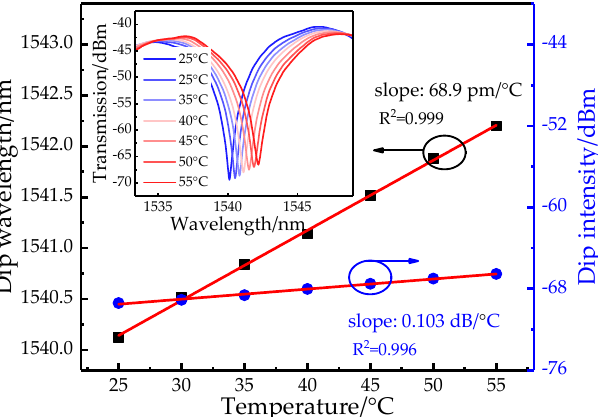
Figure 7. The wavelength and intensity responses with varied temperature. Inset: transmission spectra of SP structure.